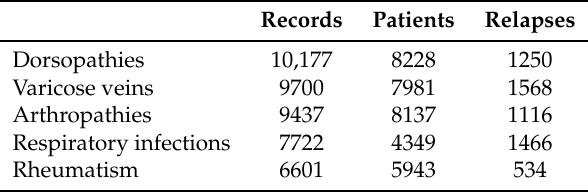
Table 2. Most prevalent diagnoses in the data